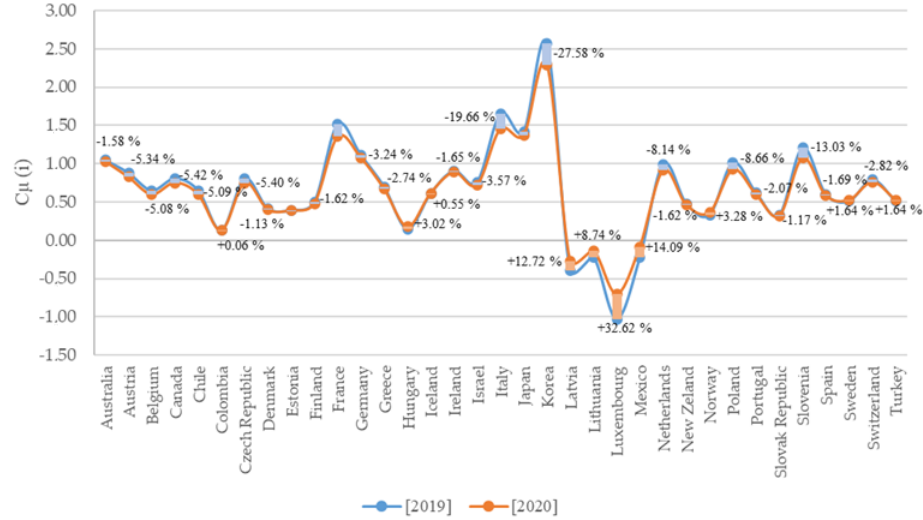
Figure 2. Alterations in the sustainability levels of the study nations, taking into account the corre- sponding evaluation indices between 2019 and 2020 using the suggested accounting method.